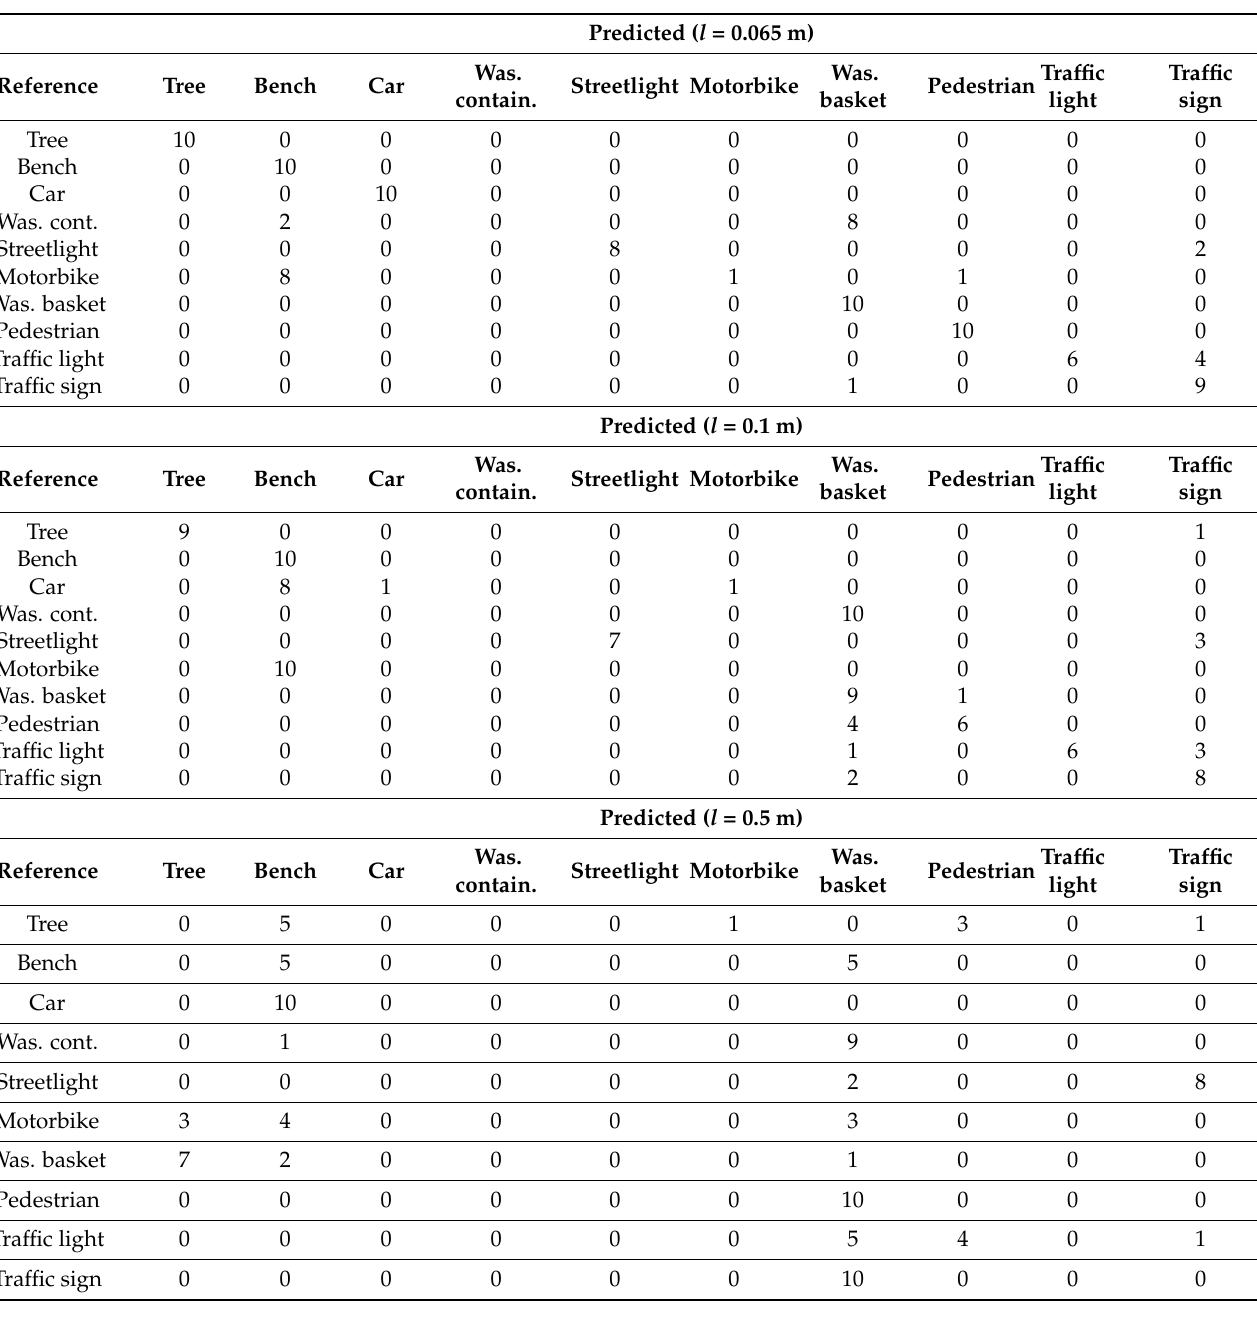
Table 4. Confusion matrices for density evaluation with l = 0.065 m, l = 0.1 m, and l = 0.5